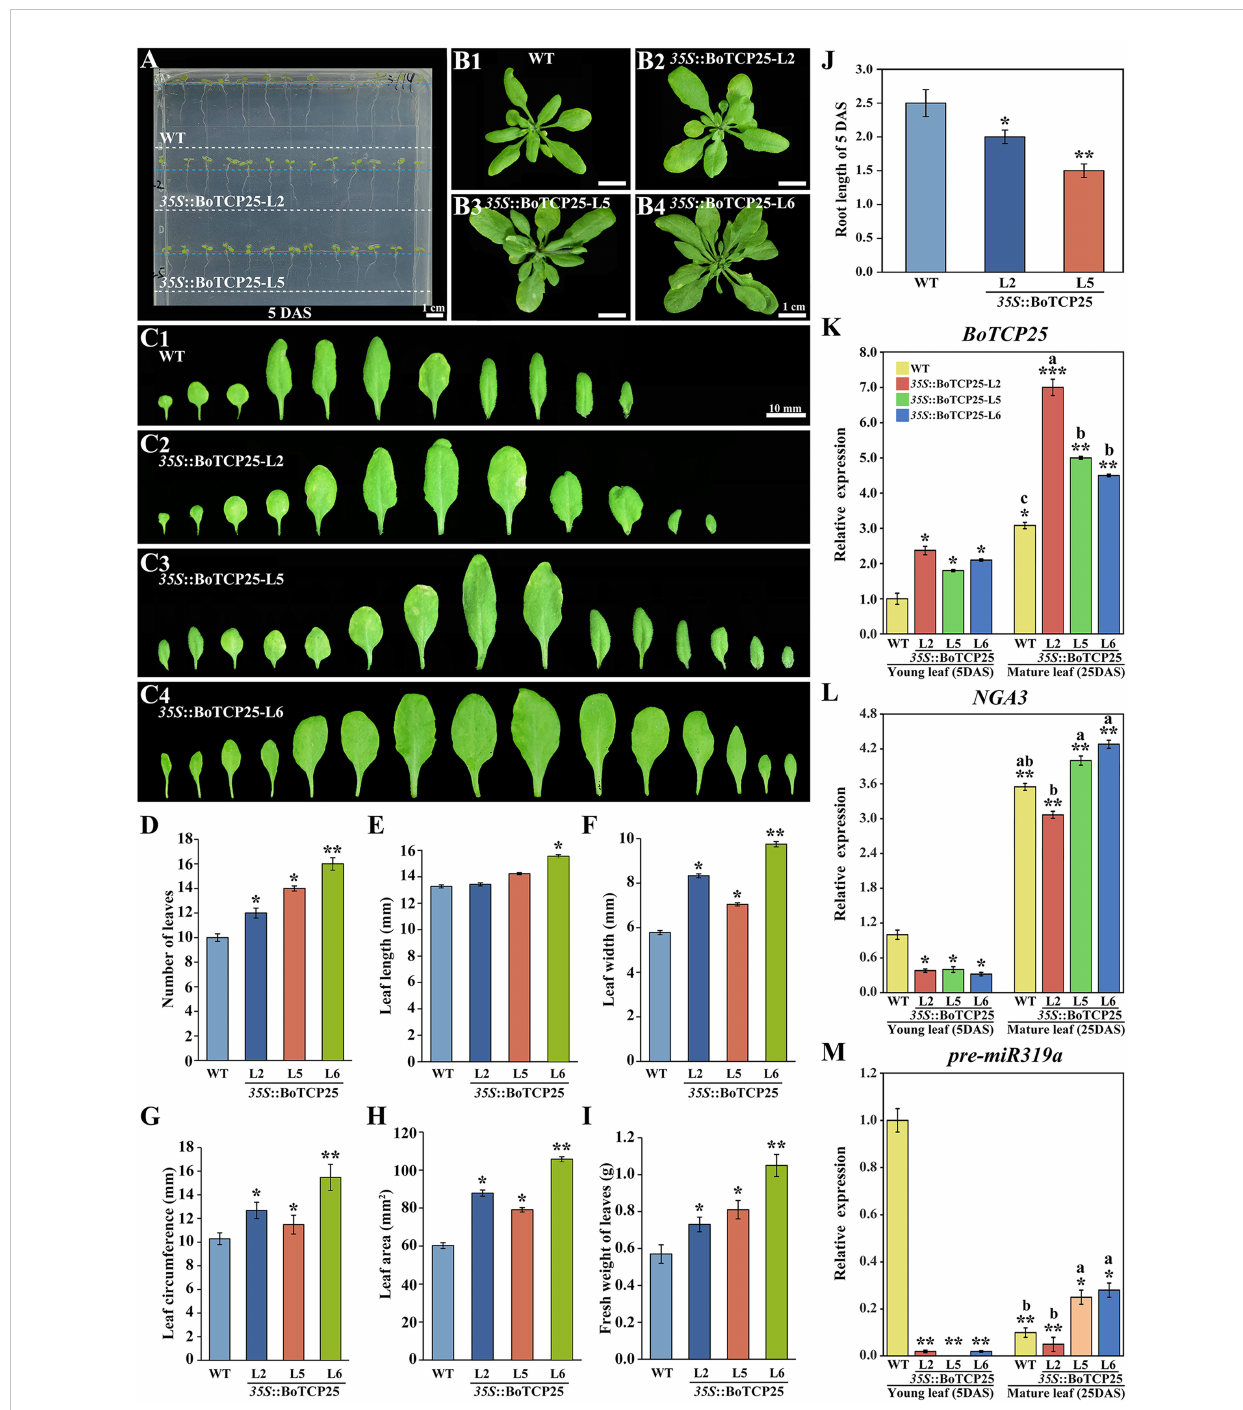
FIGURE 3 Phenotypic analysis of ectopic expressed BoTCP25 Arabidopsis plants and relative expression analysis of related genes. Phenotypic analysis of (A) 5- day-old and (B) 25-day-old pCAMBIA1302- 35S ::BoTCP25-GFP transgenic plants and the corresponding wild type. (C) Comparison of dissected leaves of three BoTCP25-GFP transgenic lines and the corresponding wild type. Statistical analysis of the number of leaves (D) , leaf length (E) , leaf width (F) , leaf circumference (G) , leaf area (H) , and fresh weight (I) of BoTCP25-GFP transgenic plants and the wildtype. (J) Root length of 5-day-old BoTCP25-GFP transgenic plants and the wild type. Relative expression of BoTCP25 (K) , NGA3 (L) , and pre-miR319a (M) in different parts of BoTCP25-GFP transgenic plants. The signi fi cant difference in leaves was marked with an asterisk (*). A single asterisk (*) means p<0.05, double asterisks (**) mean p<0.01, and three asterisks (***) mean p<0.001. Different lowercase letters represent a signi fi cant difference in mature leaves (p<0.05). The bar in A and B is 1 cm, and C is 10 mm. DAS, Days After Sowing; WT, wild type. L2, L5, and L6 are three BoTCP25-GFP transgenic Arabidopsis